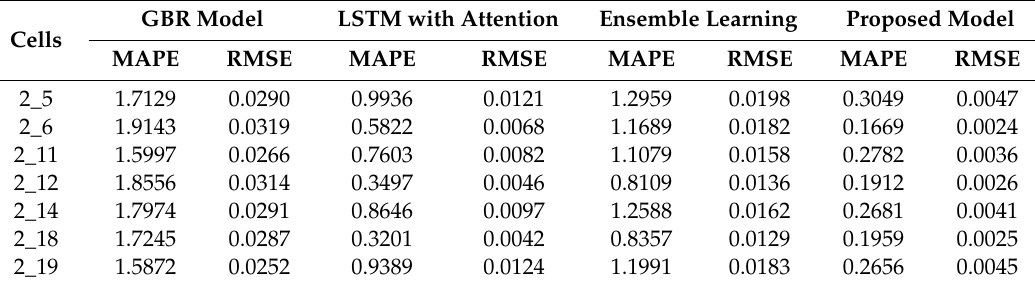
Table 3. Capacity degradation prediction of different models.